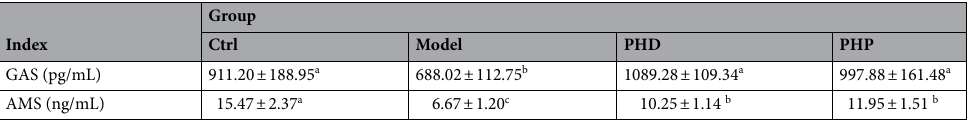
Table 2. Effects of PHD and PHP on gastrin (GAS) and amylase (AMS) in the serum. Data are expressed as mean ± SD (n = 5). Different lowercase letters (a, b and c) were significantly different at the level of p <